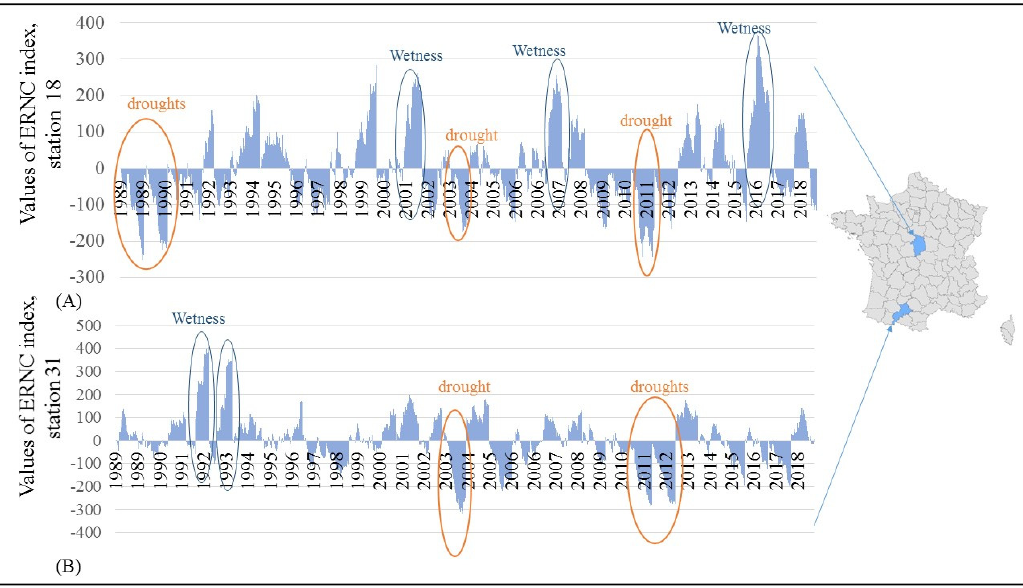
Figure 3. ERNC indices for stations 18 (A) and 31 (B) for the period 1989–2018. Examples of drought and excess of water events detected from the ERNC chronology. (A) is characterized by a southern oceanic climate with dry summers and (B) by a northern modified oceanic climate.